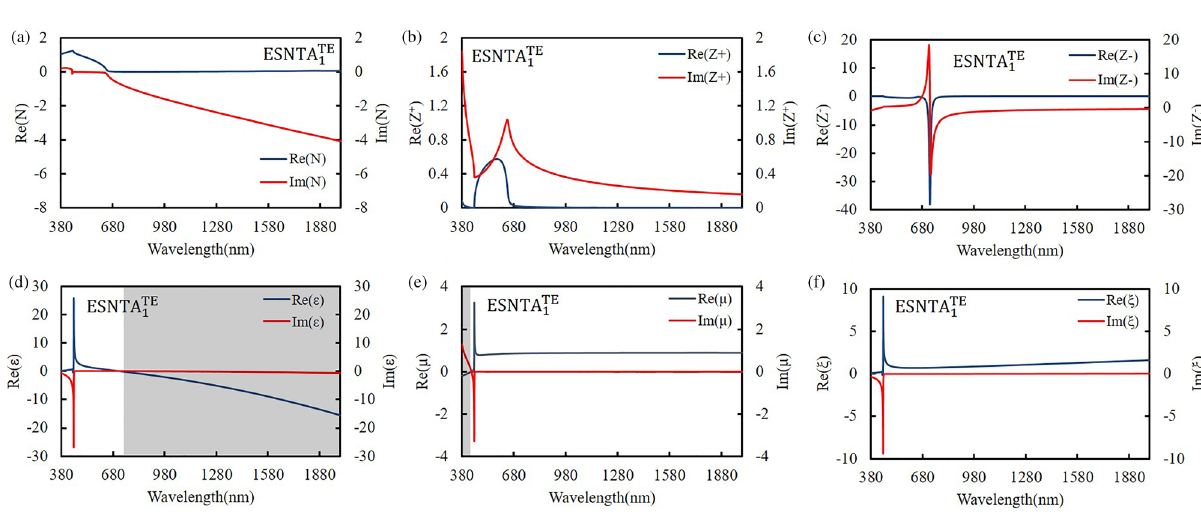
Figure 11. Retrieved ( a ) refractive index, ( b ) positive impedance, ( c ) negative impedance, ( d ) permittivity, ( e ) permeability, and ( f ) bianisotropy parameter for ESNTA 1 TE